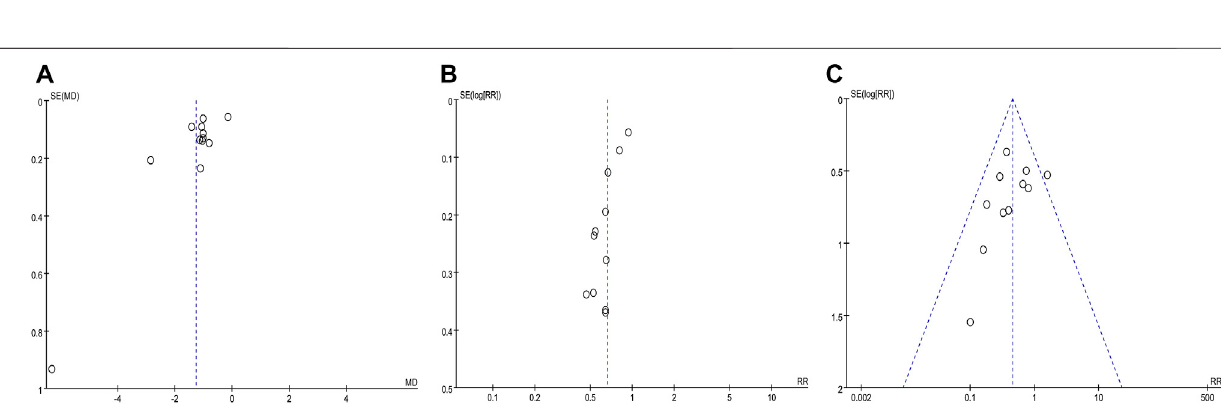
Frontiers in Pharmacology |